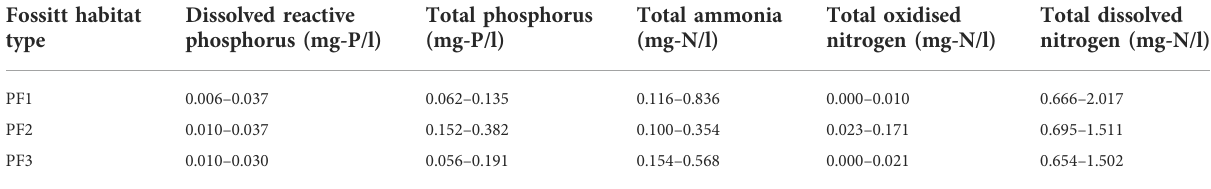
fi rst and third quartiles in boxplots of phreatic water table concentrations recorded in good fen habitats. However, it is important to note that these values should be viewed as being representative of “ remnant ” nutrients not taken up by the